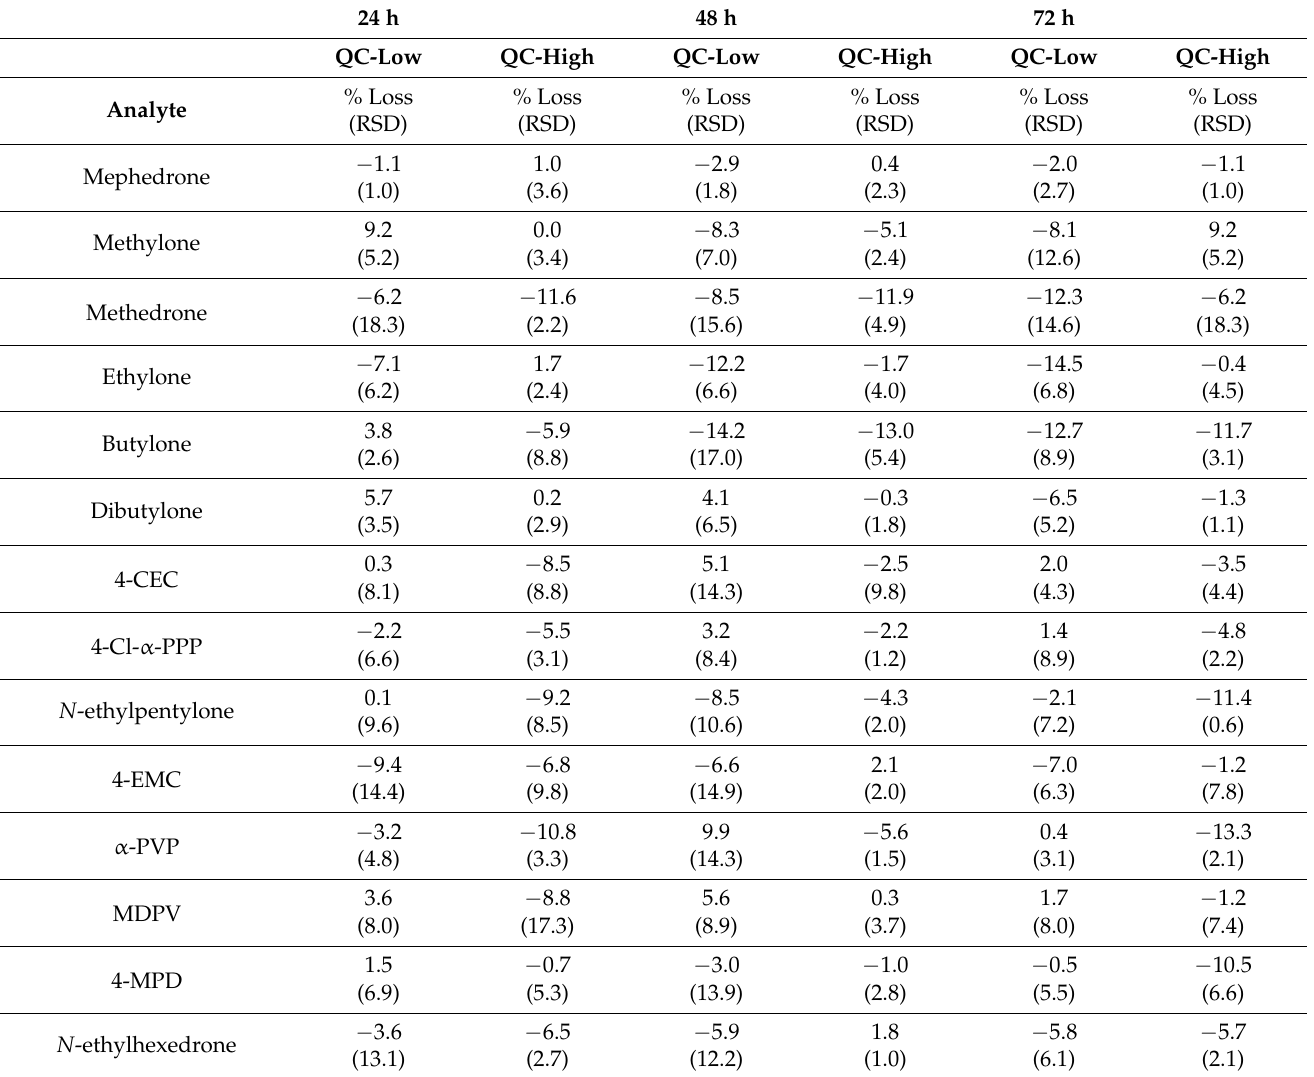
Table 4. Processed sample stability of SCts in urine after 24, 48 and 72 h of storage on